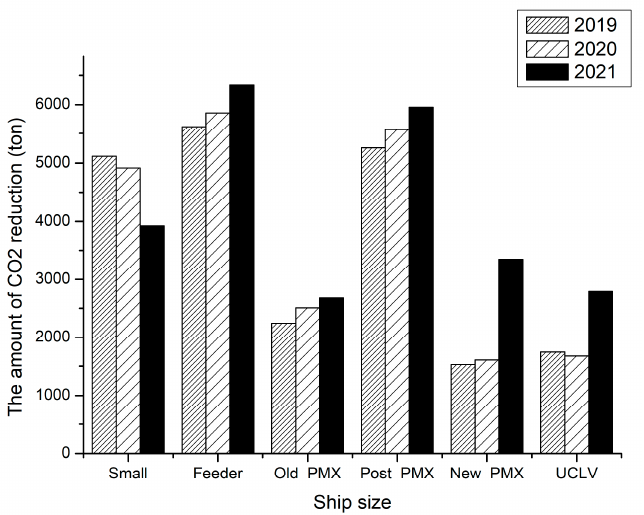
Figure 5. The trends for CO 2 emission reductions when using shore power.